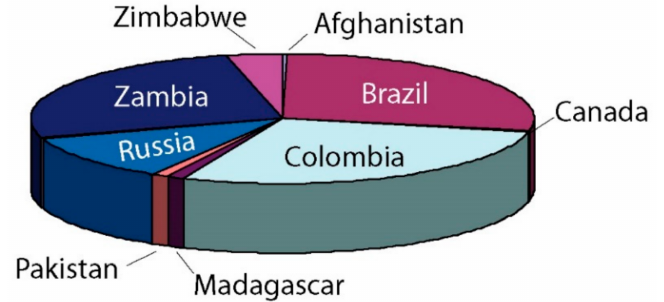
Figure 3. Emerald production worldwide in